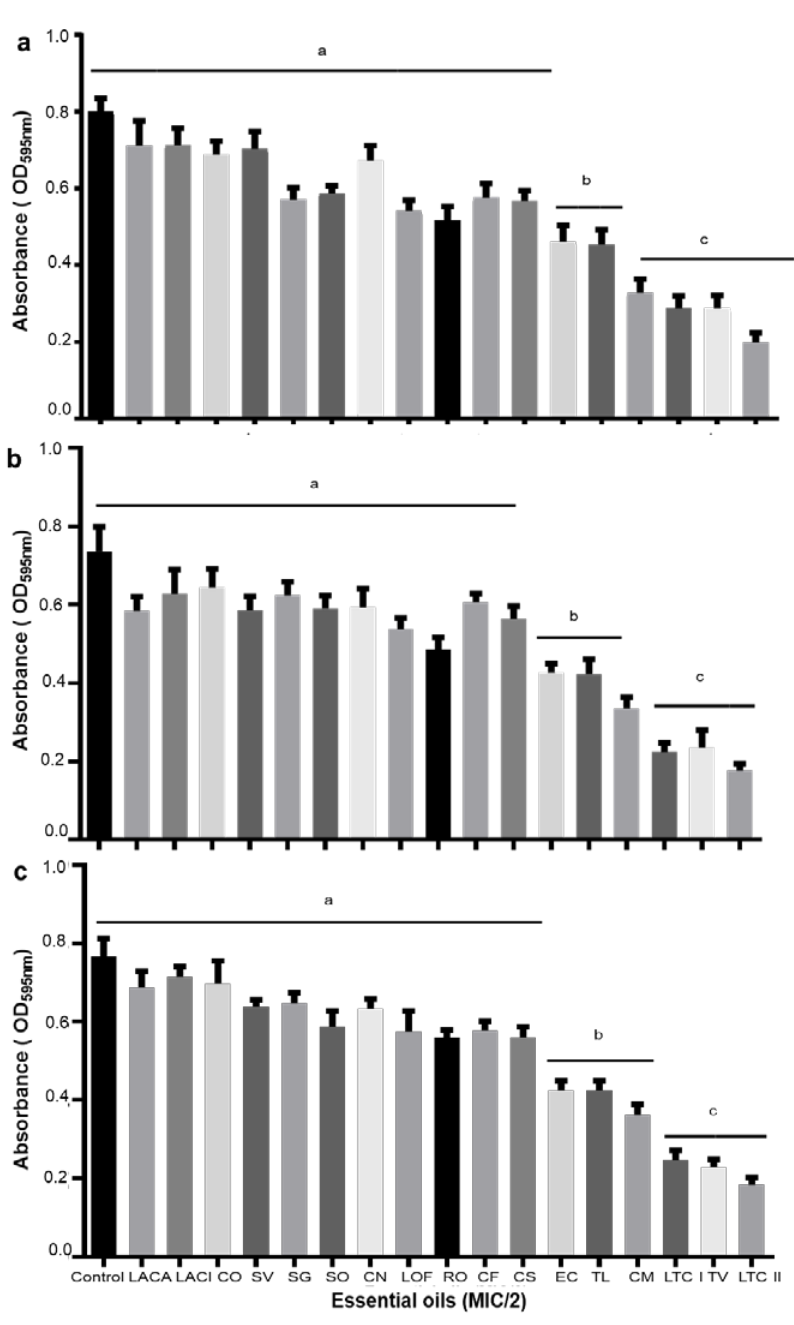
Figure 3. Anti-biofilm activity of different essential oils (at MIC 50 /2 concentration) on bacterial strains. E. coli O157:H7 ( a ), E. coli O33 ( b ), and S. epidermidis ATCC 12228 ( c ). Lippia alba carvone chemotype (LACA), Lippia alba citral chemotype (LACI), Cananga odorata (CO), Satureja viminea (SV), Swinglea glutinosa (SG), Salvia officinalis (SO), Cymbopogon nardus (CN), Lippia origanoides felandrene chemotype (LOF), Rosmarinus officinalis (RO), Cymbopogon flexuosus (CF), Citrus sinensis (CS), Elettaria cardamomum (EC), Tagetes lucida (TL), Cymbopogon martini (CM), Lippia origanoides thymol-carvacrol chemotype (I) (LTC I), Thymus vulgaris (TV), and Lippia origanoides thymol-carvacrol chemotype (II) (LTCII). The bars on the graph represent mean ± SD of biofilm inhibition of triplicate experiments. The ANOVA test showed a statically significant difference relative to control ( p < 0.05). with a significance level of 95% and a mean comparison Tukey’s test with an α error of 0 .05. Different letters indicate significant differences between the test groups.